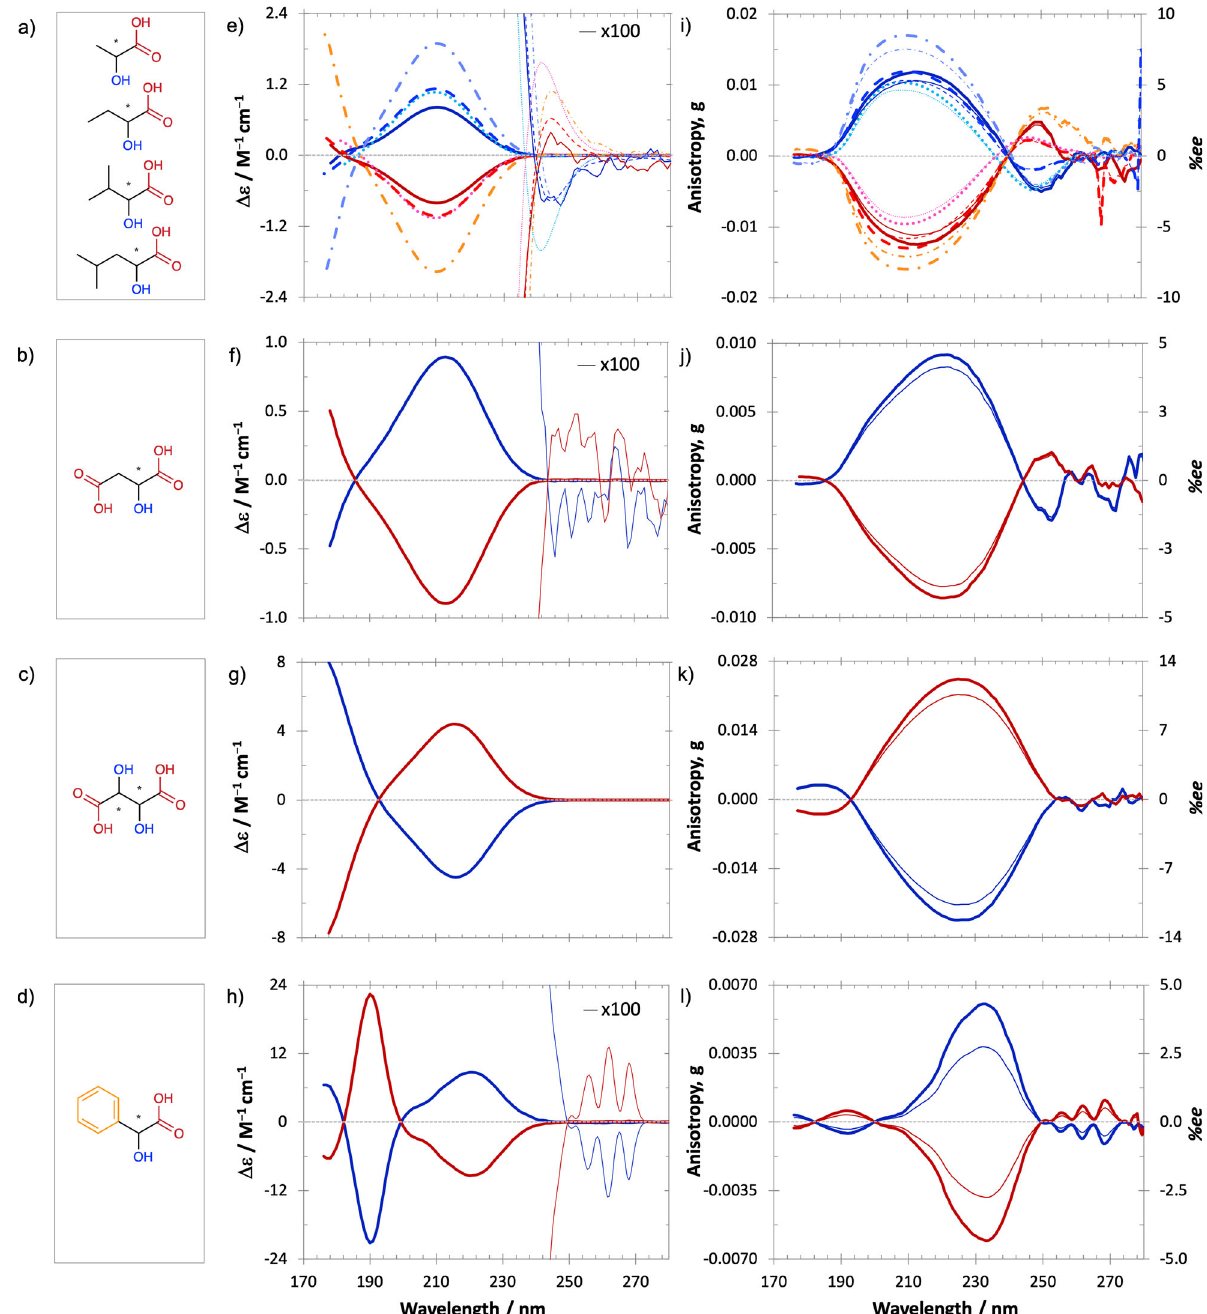
Fig. 1 CD and anisotropy spectra of chiral hydroxycarboxylic acids in aqueous solution. Schematic structures of a lactic, 2-hydroxybutanoic, 2-hydroxy- 3-methylbutanoic and 2-hydroxy-4-methylpentanoic; b malic; c tartaric and d mandelic acid. e – h Corresponding electronic circular dichroism spectra of the HCAs; e lactic (solid dark blue/red line), 2-hydroxybutanoic (dashed blue/red line), 2-hydroxy-3-methylbutanoic (dotted turquoise/pink line), 2-hydroxy- 4-methylpentanoic acid (dash-dotted purple/orange line). i – l Corresponding anisotropy spectra of the HCAs (thick) and the lower limit of the inducible enantiomeric excess ( %ee) by either left- or right-circularly polarised light (thin) as a function of wavelength at the extent of reaction ξ = 0.9999 calculated based on the relation (1). The D -enantiomers ( R -; except for tartaric acid where D -tartaric acid is 2 S -, 3 S -) are in shades of red and the L -enantiomers ( S -; except for tartaric acid where L -tartaric acid is 2 R -, 3 R -) are in shades of blue. The collection of curves in ( e ) and ( i ) is shown separately for each compound in Supplementary Fig.